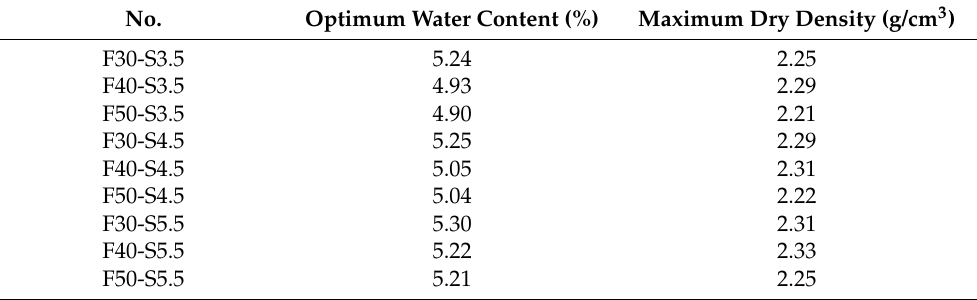
Table 2. RAP concrete mix design.